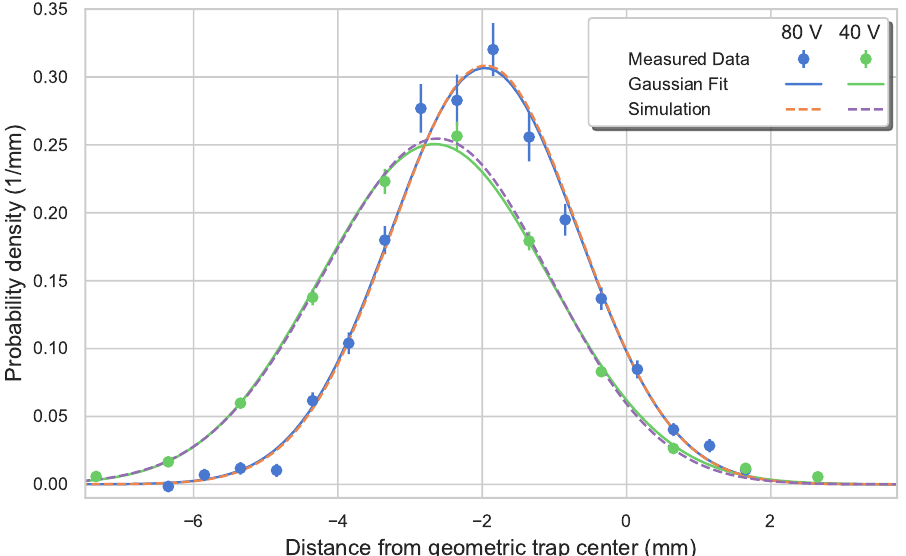
Figure 7. Characterization of surface charge accumulation on PCBs. The surface charge distribution is defined such that the tomography measurements for 80 V endcap voltage matches the simulated ion distribution at a temperature of 373 K. Once the charges are fixed, the modified potential is used to obtain the ion distribution for a configuration with 40 V endcap voltage, which matches the measured ion density distribution for the chosen endcap